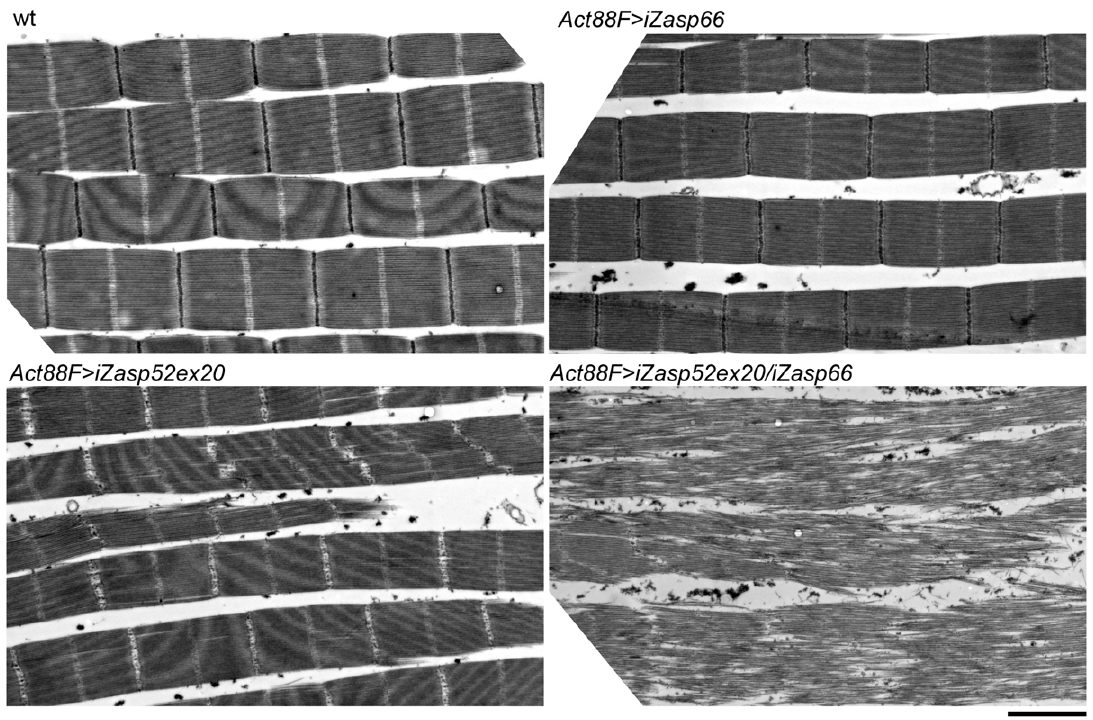
Figure 10. Zasp52 and Zasp66 cooperate to assemble myofibrils. Electron micrographs of IFM of wild type, Act88F . iZasp66, Act88F . iZasp52ex20, and Act88F . iZasp52ex20/iZasp66 double mutants. Global views are shown. The double mutant shows a severe disruption of sarcomere structure, at the level of the Z-disc as well as the filament system, where fraying and misaligned thick and thin filaments can be observed. Scale bar, 2 m m.